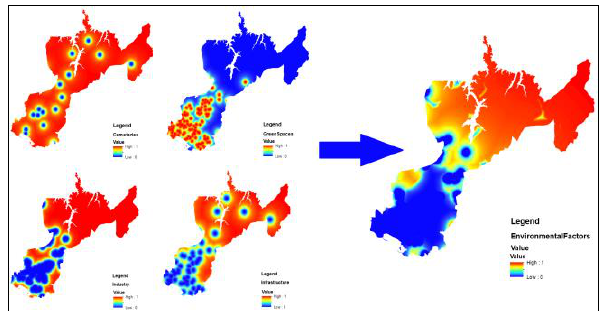
Figure 1. Creation of the Fuzzy Surface of Environmental Factors